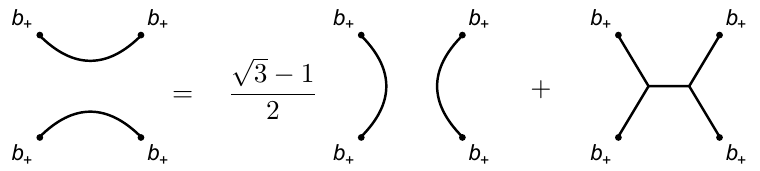
Figure 54 . An example of a crossing equation for the four-point function of b + connected by an H-junction. In this example, the internal line on the l.h.s. is the trivial line. On the r.h.s. , we have p 3 (cid:0) 1 used e K Y;Y ( I; I ) = , h a i b + b + i = 0, and h b + b + b (cid:0) i v Y;Y 2 and h b + ; b + b + i v = 0 by the nontriviality of the cyclic permutation map when acting on v 1 . 1